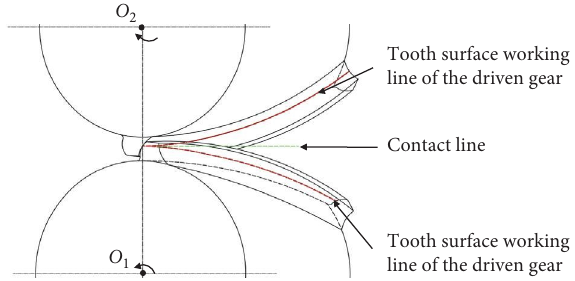
F IGURE 7: Schematic diagram of the contact line and tooth surface working